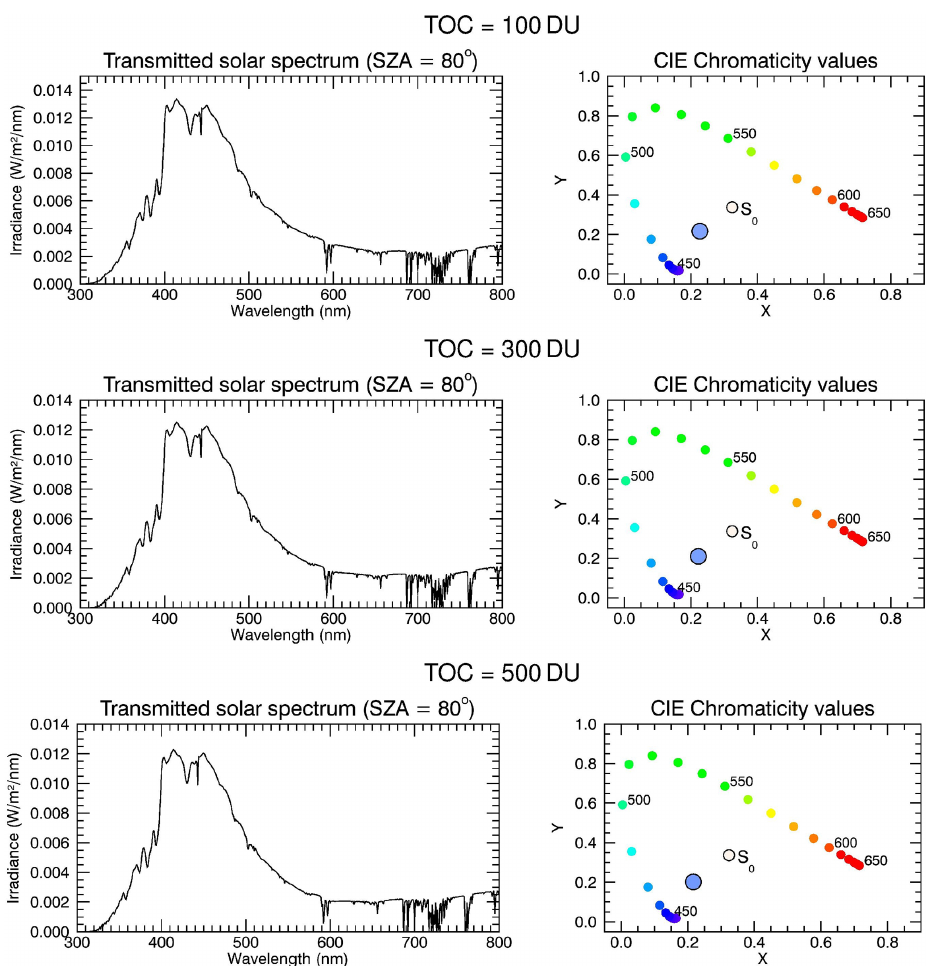
Figure 9. Similar to Fig. 4 but for different total ozone columns (top panel: 100DU; middle panel: 300DU; bottom panel: 500DU).